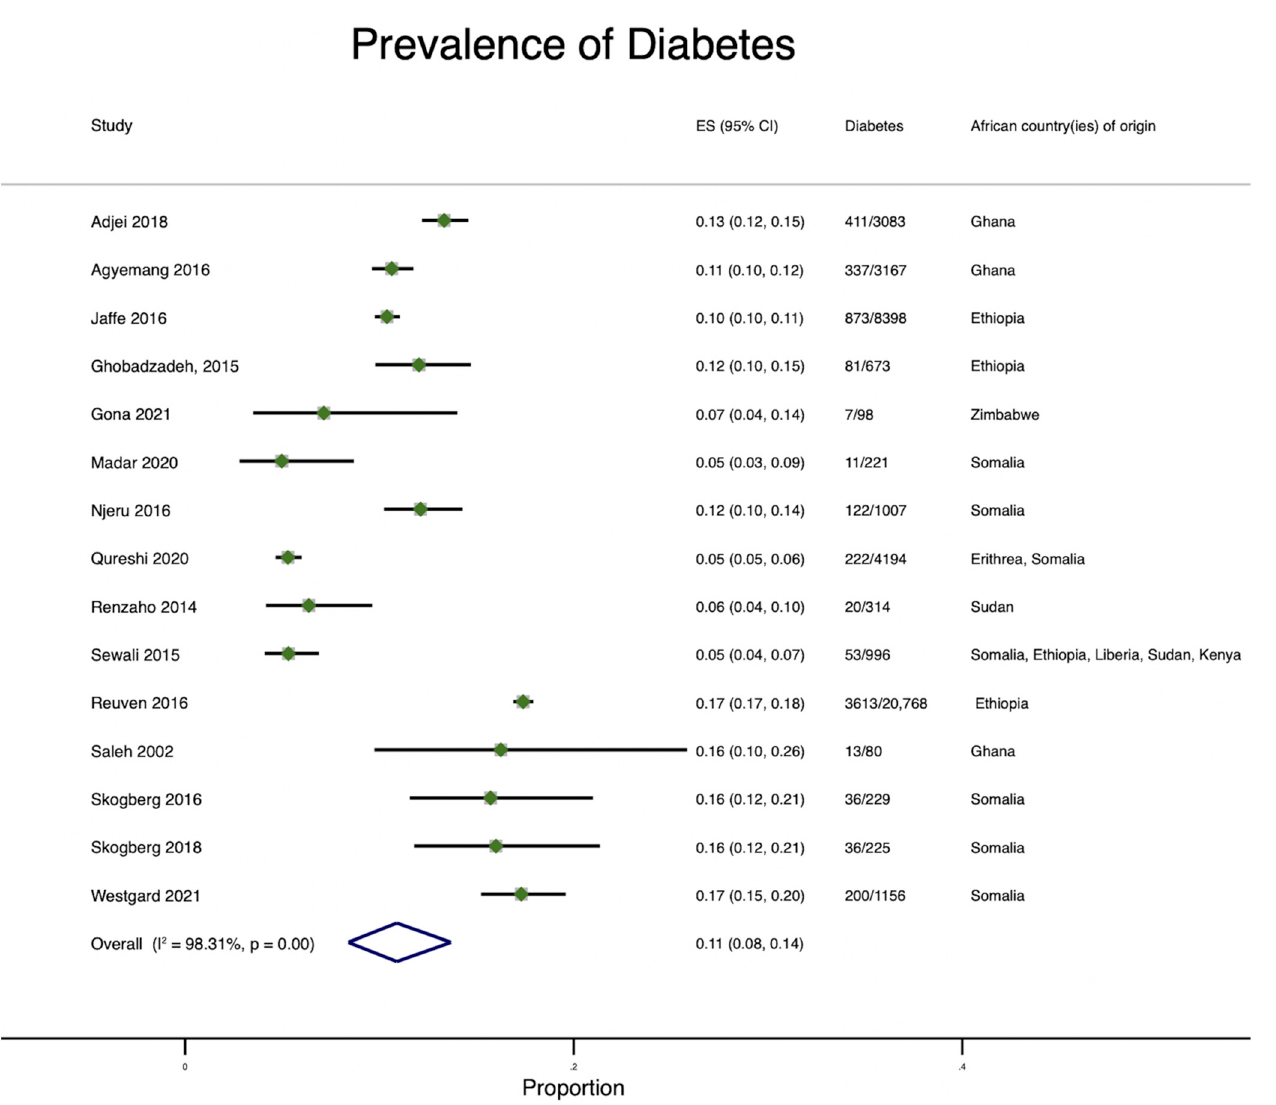
Figure 4. Pooled Prevalence of diabetes among African immigrants residing in high-income coun- tries.